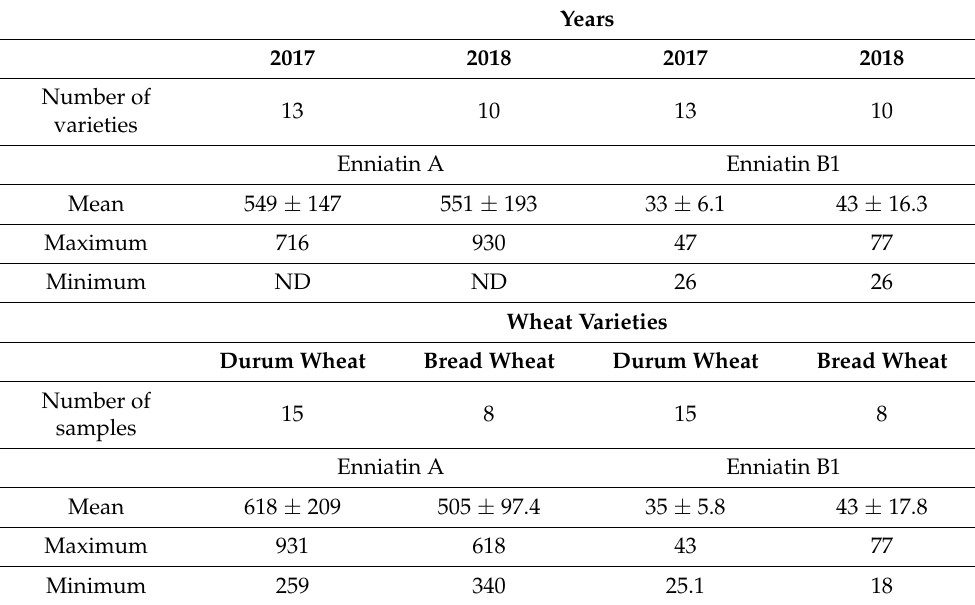
Table 2. Levels of enniatin analogues (mg Kg − 1 ) in Tunisian wheat grains from different varieties comparing crop years (2017 vs. 2018) and cultures (Durum vs. Bread